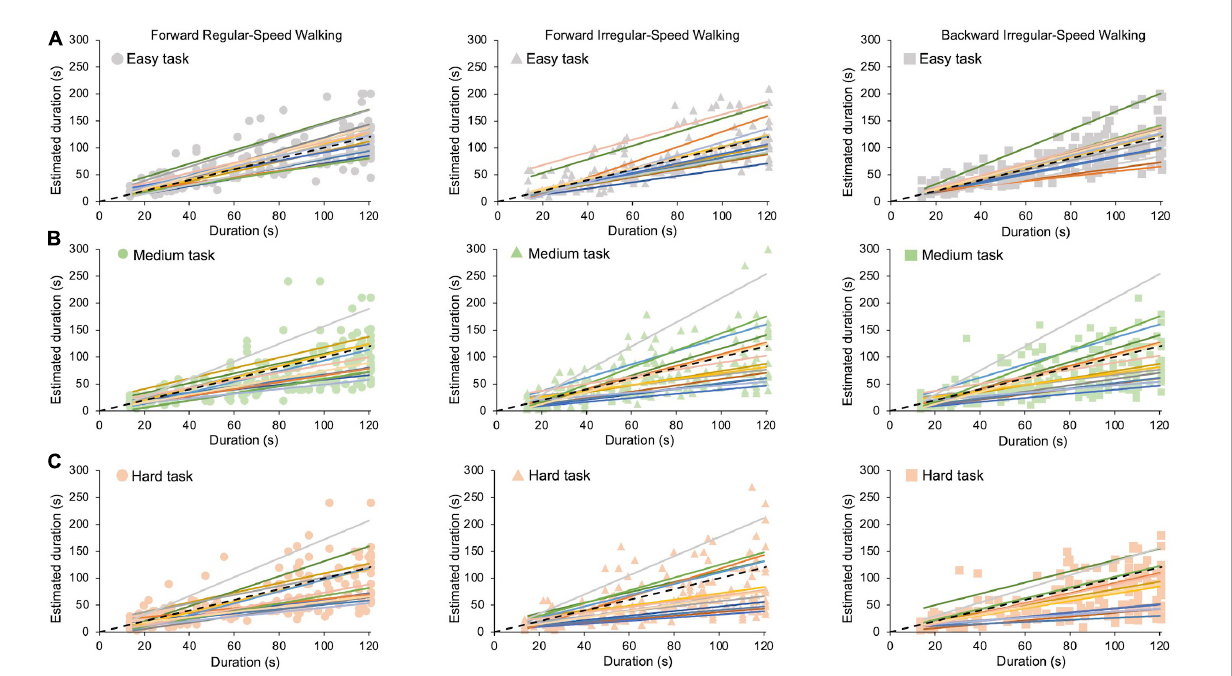
FIGURE2 Time estimation in different motor and cognitive tasks. Each colored fit line is the average time estimate of the same participant. Dots indicate the forward regular-speed walking condition (left panels); triangles indicate the forward irregular-speed walking condition (middle panels); squares indicate the backward irregular-speed walking condition (right panels). Dashed black lines represent exact estimations. (A) Easy task. (B) Medium task. (C) Hard